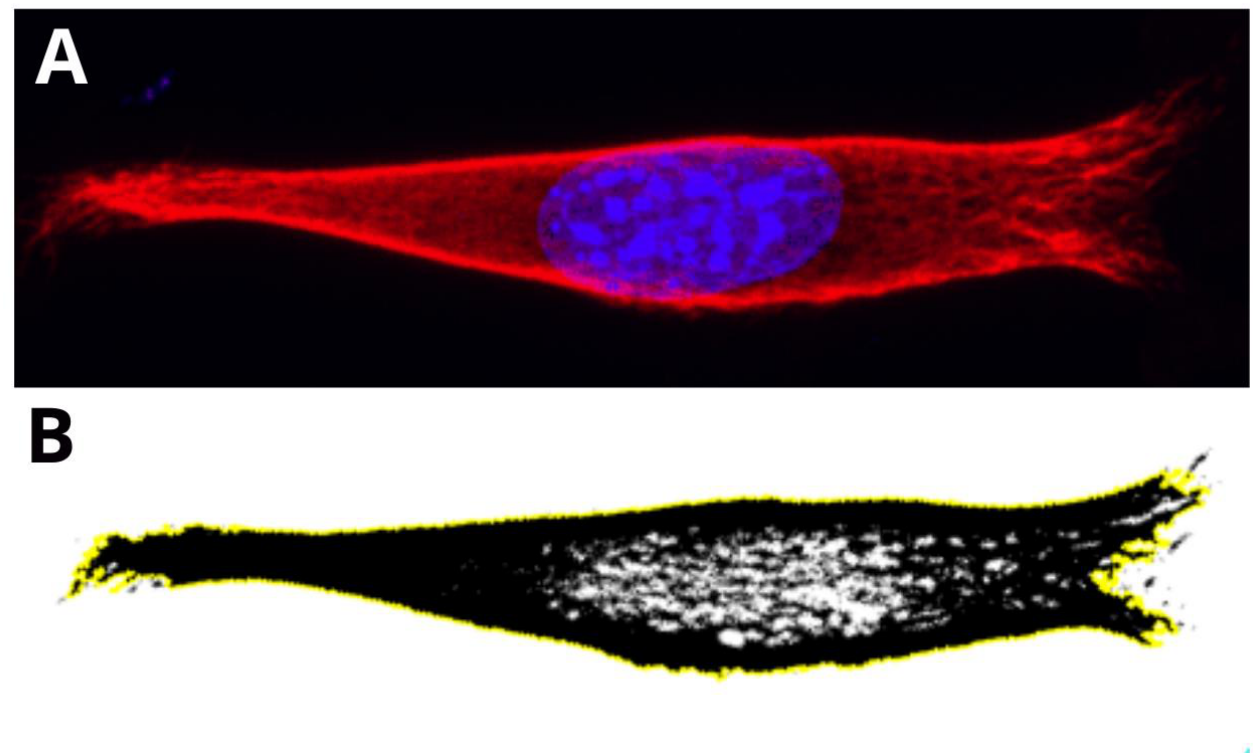
Figure 5. Presentation of a step performed for analysis of the vimentin cytoskeleton. Example of a nutshell structure of MEF cell cultured on PLA. ( A ) The cell is cropped, and image parameters are adjusted initially. ( B ) 16-bit (B&W) image of the vimentin cytoskeleton, after selection of ROI (region of interest — yellow line) based on color thresholding.